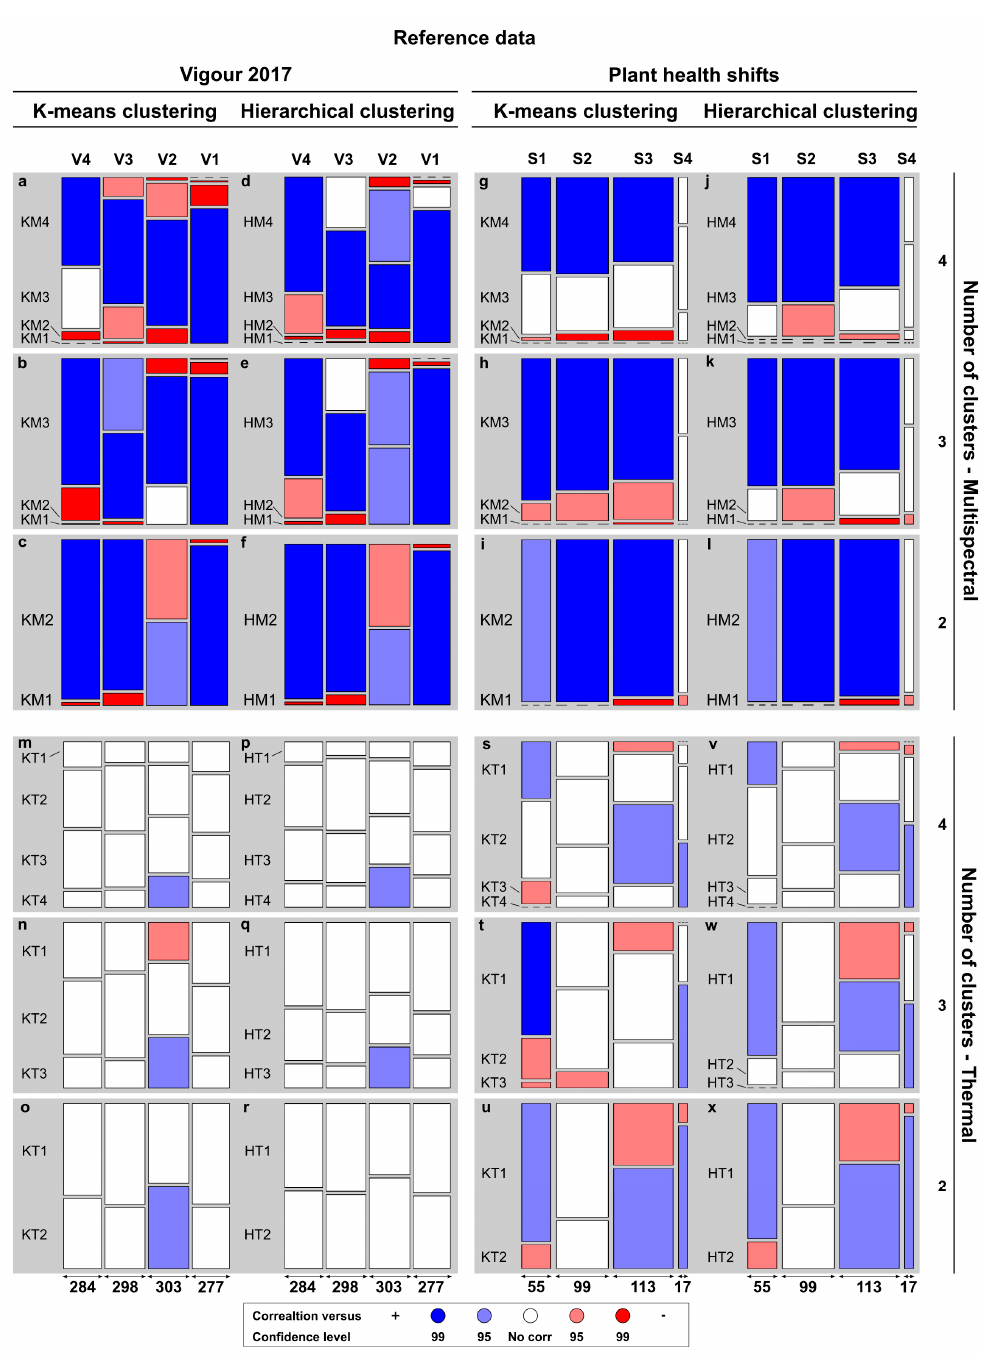
Figure 2. Correlation between clusters and reference data. ( a–f ) and ( g–l ) show the correlations of multispectral clusters with plant vigour and health shift classes, respectively. Results obtained from the K-means method are reported in ( a–c ) and ( g–i ), while those from hierarchical clustering are in ( d–f ) and ( j–l ). ( m–r ) and ( s–x ) picture the correlation of thermal clusters with plant vigour and health shift classes, respectively. ( m–o ) and ( s–u ) report the results from K-mean clustering, while ( p–r ) and ( v–x ) report those from the hierarchical method. White represents non-significant correlation. Positive and negative correlations are highlighted in blue and red, respectively, and shaded in relation to their confidence level (Pearson test): 95% confidence in brighter colours, 99% in darker tones. The bases of the rectangles are proportional to the total number of images within each reference class (numbers at the bottom of the graph), whereas heights are the proportion of reference data within the specific cluster.